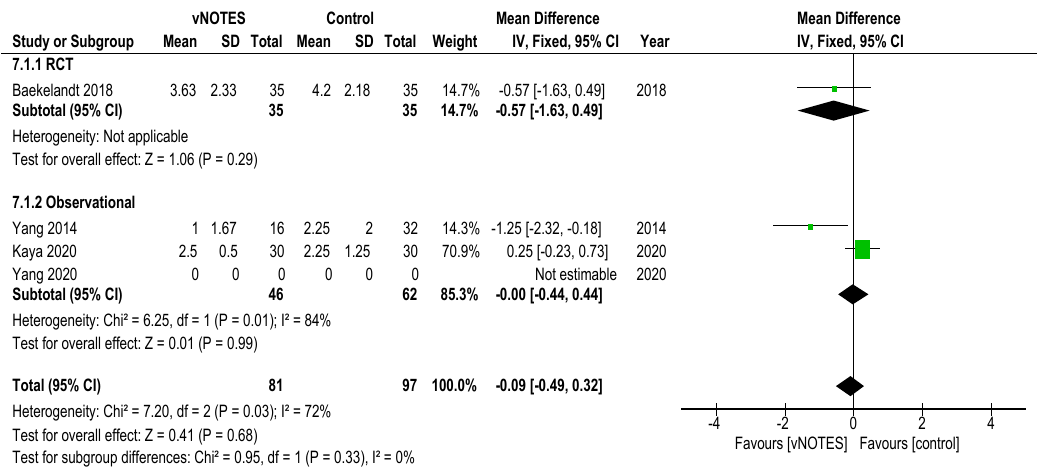
Figure 5. Forest plot of comparison vNOTES versus control, outcome: length of hospital stay.